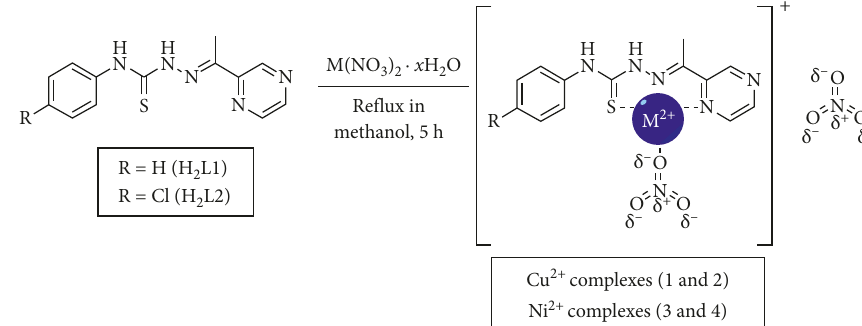
Scheme 2: Obtaining copper and nickel complexes with thiosemicarbazone